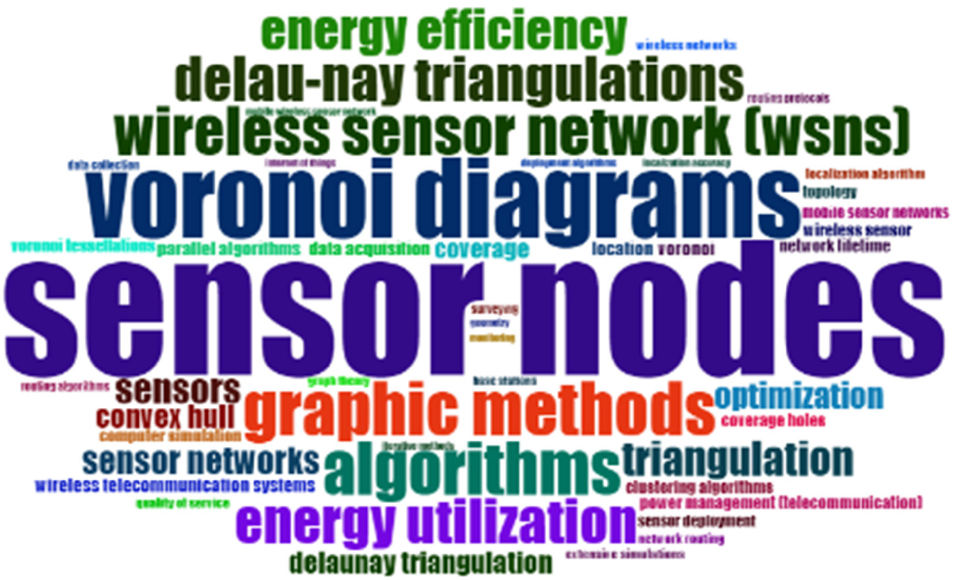
Figure 1. A word cloud of keywords.